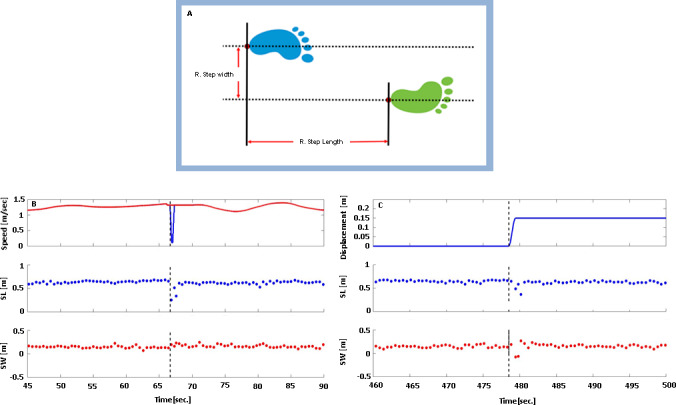
Step width and step length calculation and sample data.(A) Illustration of step length and step width calculation. (B) Step length and step width behavior in response to anterior-posterior treadmill belt perturbation. Top panel: trace of treadmill belt speed shows treadmill perturbation profile; red–right belt, blue–left belt (seen only at time of perturbation, as the two belt speeds were otherwise identical); middle panel: trace of step length values prior to and post perturbation; lower panel: trace of step width values prior to and post perturbation. (C) Step length and step width behavior in response to medio-lateral platform perturbation. Top panel: trace of platform displacement shows platform perturbation profile (positive values = right direction); middle panel: trace of step length values prior to and post perturbation; lower panel: trace of step width values prior to and post perturbation. Negative step length values represent backward steps of the recovering limb, while negative step width values represent a crossover step with the leading limb. (B) and (C) depict 45 and 40 seconds, respectively, of walk trials from one participant. Values from the right and left leg are depicted in all panels (alternating; not distinguished in the trace). Vertical dashed line represents perturbation onset time.